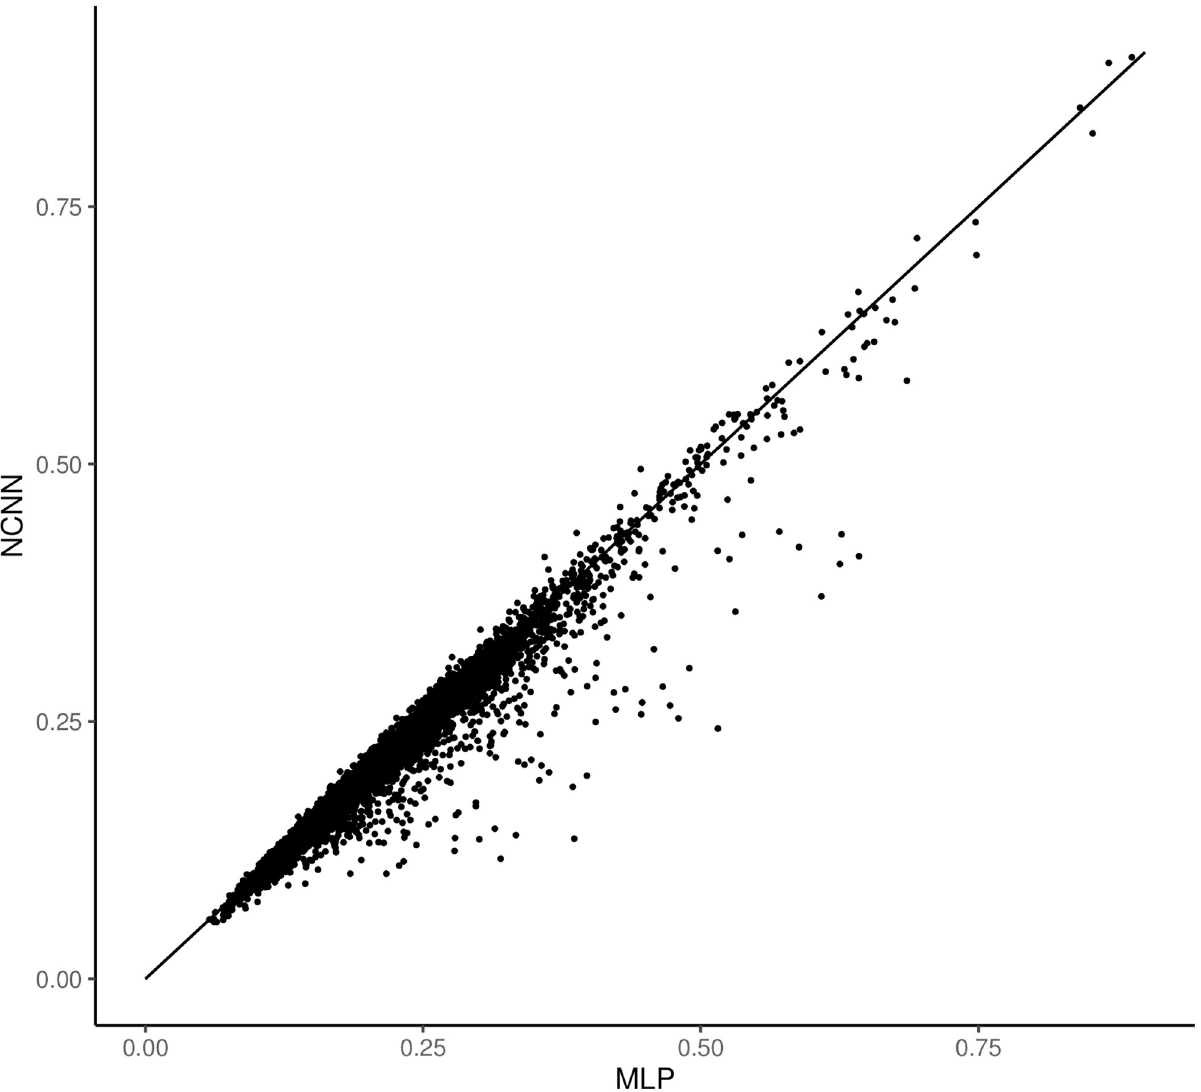
Fig 7. The comparison of mean average error of predictions on each gene in GTEx dataset. The y value is the mean average error from NCNN model on each target gene; the x value is the mean average error from MLP model on each target gene. Each dot below the diagonal means that NCNN has lower prediction error on this gene than the comparing